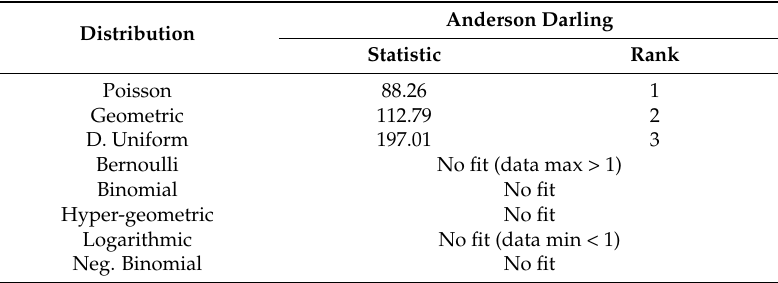
Table 2. The results of statistical tests for determining the fitting of the input flow to a certain distribution.